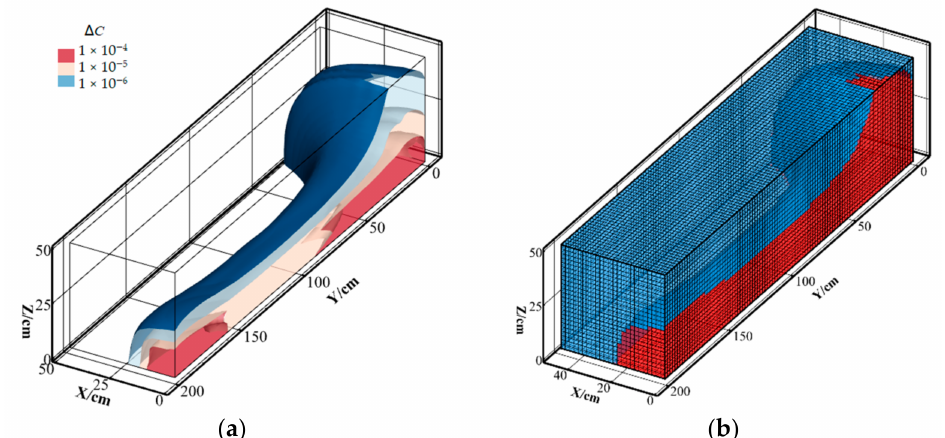
Figure 4. Spatial decomposition of the neutron streaming shielding problem. ( a ) The distribution of the contribution function; ( b ) the spatial decomposition with tolerance ∆ C = 1 × 10 − 5